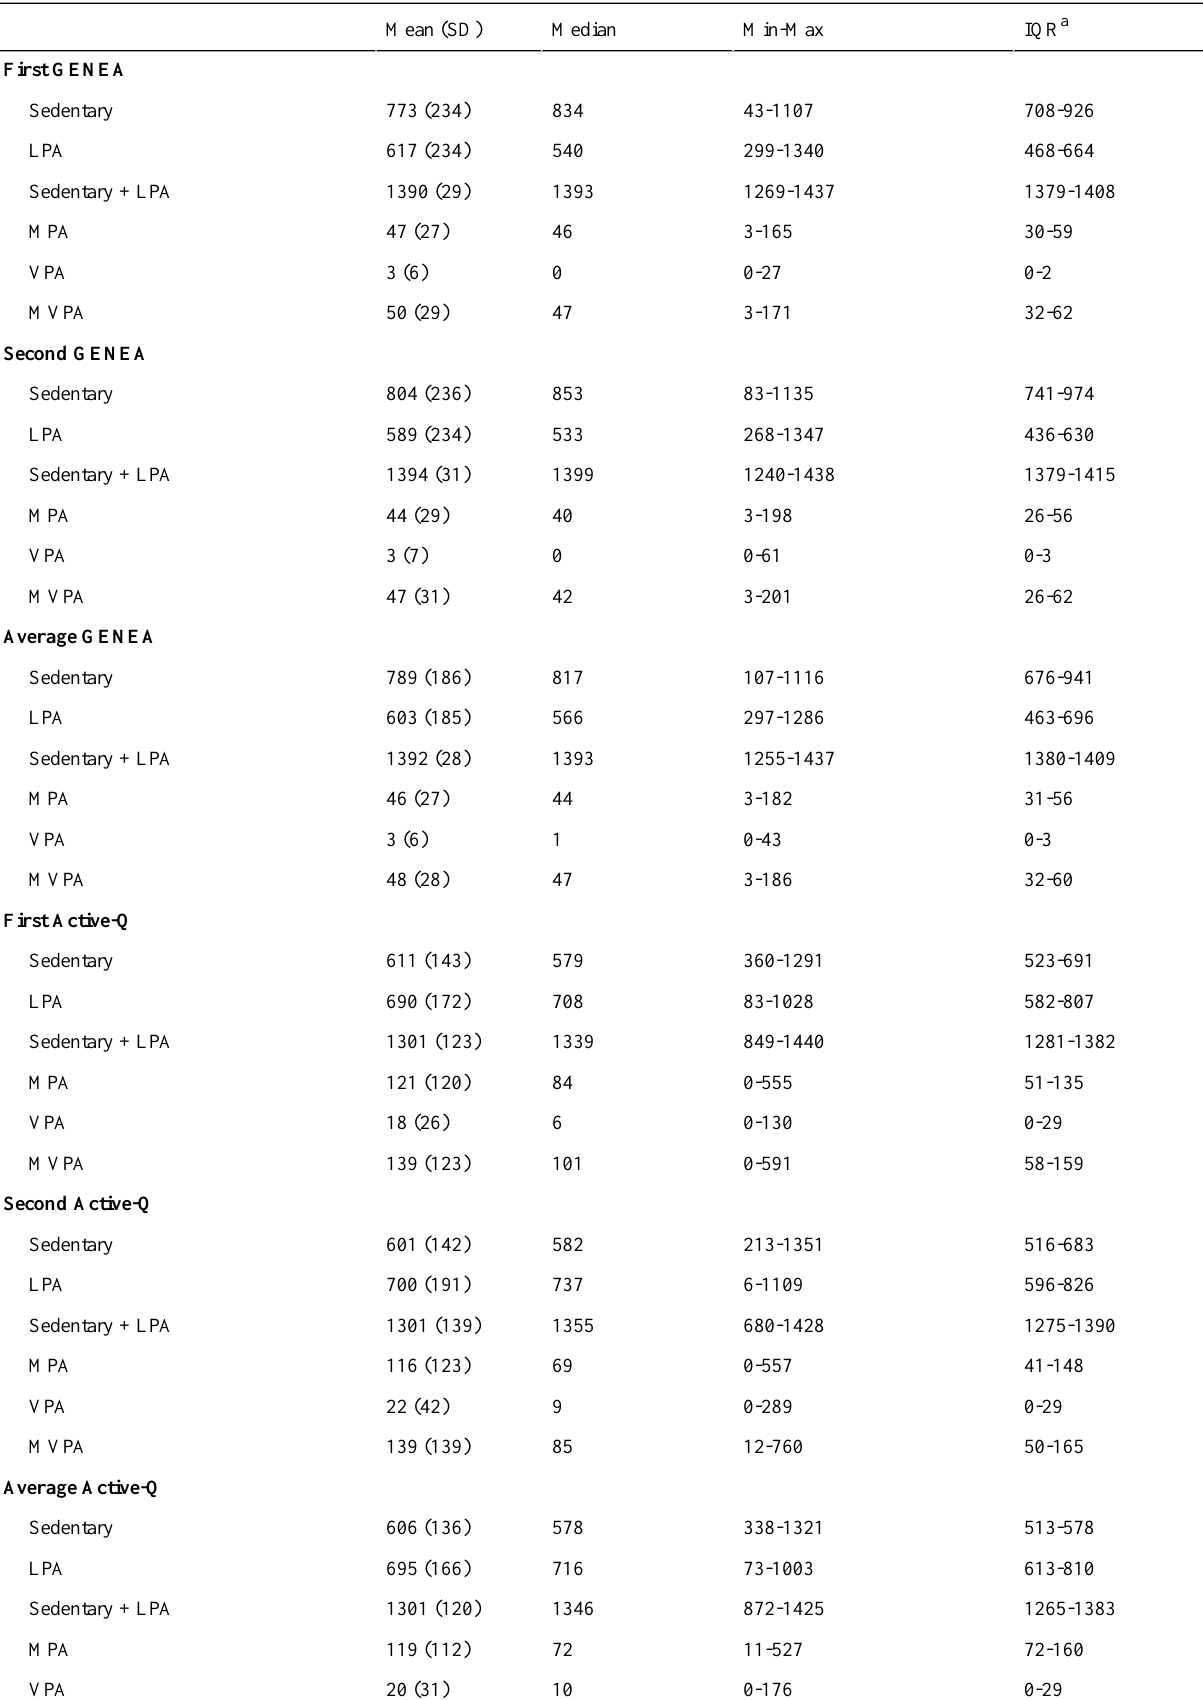
Table 3. Results of time in minutes per day spent at light (LPA, <3 MET), moderate (MPA, 3-6 MET), vigorous (VPA, >6 MET), and moderate-to-vigorous (MVPA, ≥ 3 MET) physical activity levels assessed by GENEA and Active-Q